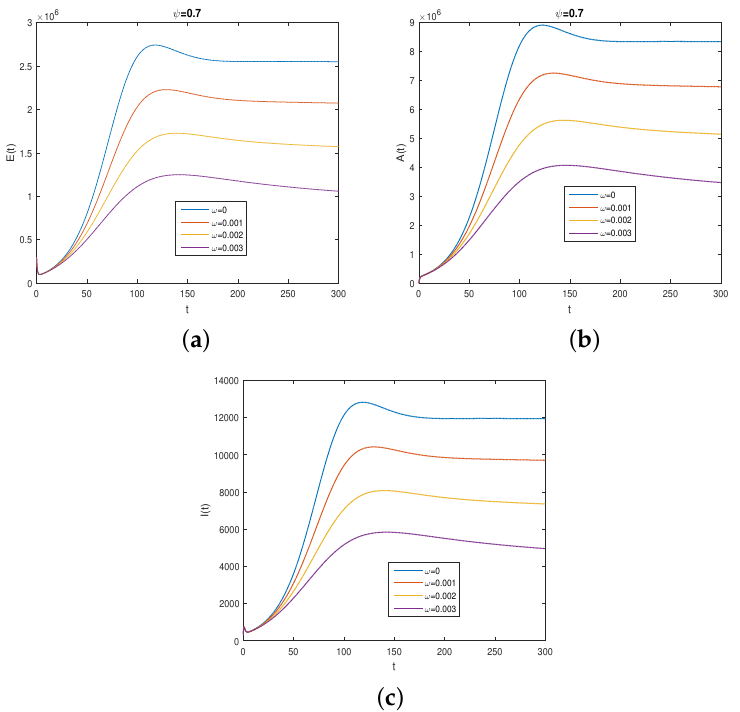
Figure 6. Impact of the vaccination rate on the components of the system for different values of ω and efficacy, ψ = 0.7 and η = 0.95. Subfigures ( a – c ) describes the dynamics of exposed, asymptomatic, and symptomatic individuals respectively.